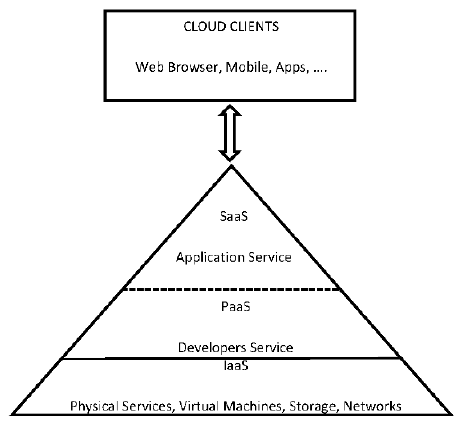
Figure 1. Cloud Service Models.